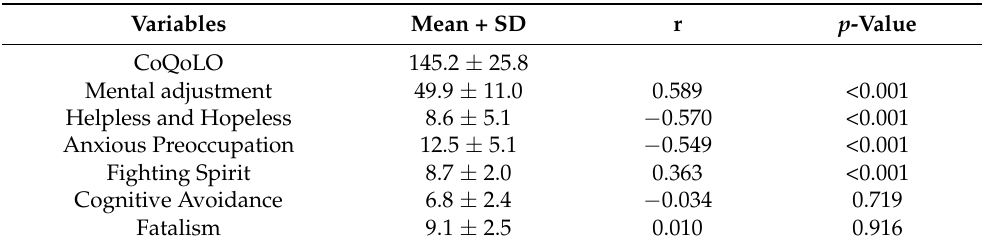
Table 2. Correlation of mental adjustment and its dimensions with comprehensive quality of life outcome (CoQoLO) among terminally ill cancer patients (N =